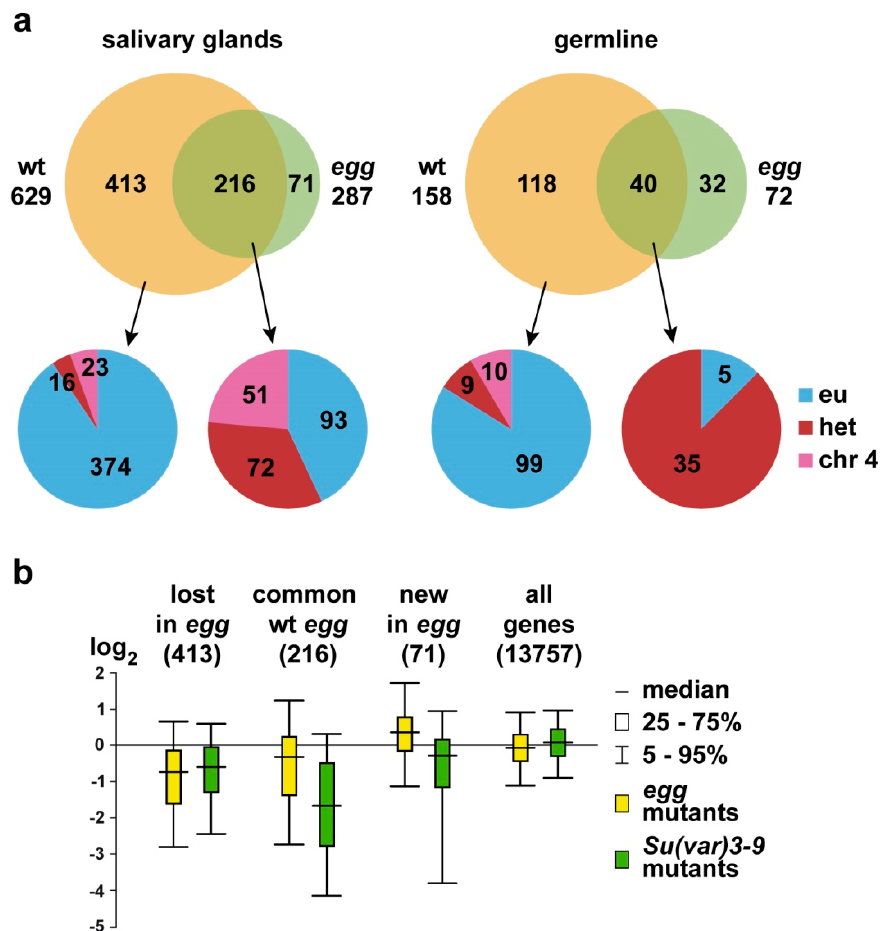
Figure 1. ( a ) Venn-diagrams indicating the numbers of SU(VAR)3-9 targets in the chromosomes from salivary glands and germline of wild type (wt) and egg mutants (upper row); distribution of SU(VAR)3-9 targets showing distinct response to egg mutation across euchromatin, heterochromatin, and the chromosome 4 (bottom row). ( b ) Changes in H3K9me2 binding in mutants ( egg or Su(var)3-9 ) in comparison with wild type across the thee groups of genes, as well as genome-wide. Gene counts in each group are shown in brackets. Box-plot diagram is based on the original data on H3K9me2 distribution in the salivary gland chromosomes [35]. Chromosome-wide H3K9me2 enrichment across 30 bp intervals was calculated as log 2 (IP / input) and median values for each gene were defined. Box plots show the range of values obtained by subtracting the median gene enrichment values in wild type animals from those in mutants.